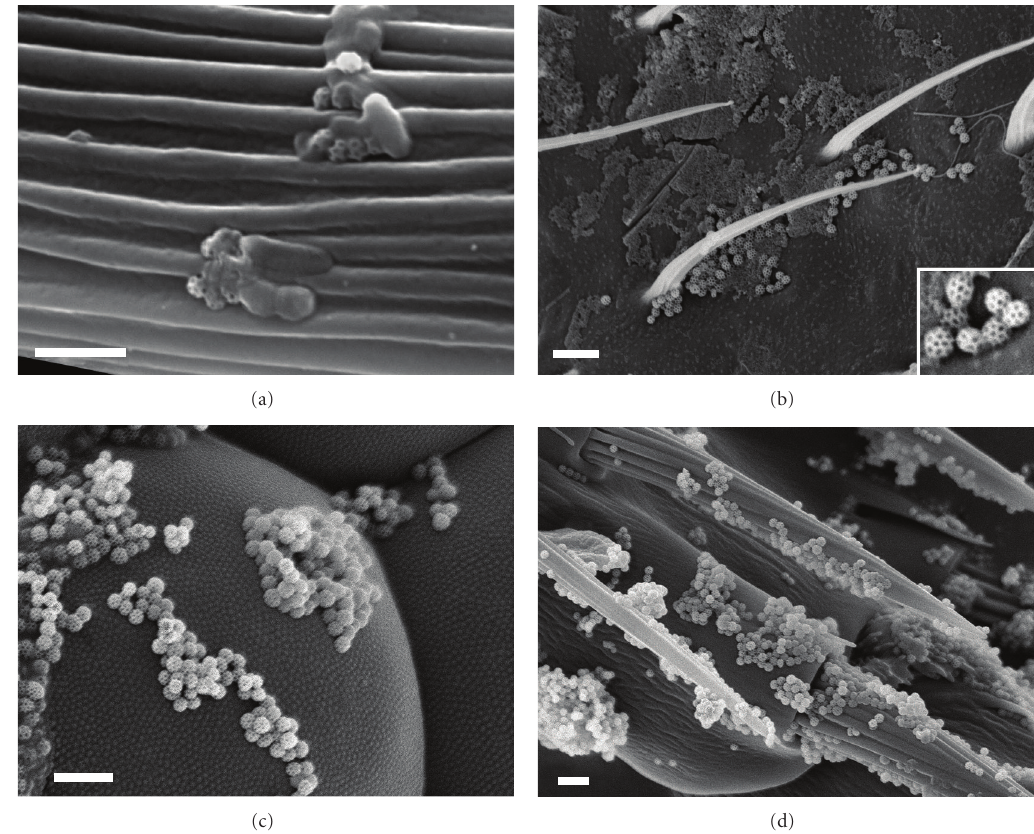
Figure 1: Insect integuments contaminated with brochosomes. (a) Pulvillus of Sthenarus rotermundi reared in captivity, showing the largest concentration of brochosomes (12 particles) observed among heteropteran specimens in this study and some bacteria. (b) Wing of Drosophila melanogaster kept in ethanol together with leafhoppers; inset: close-up of brochosomes. (c) Eye of D. melanogaster kept within a leafhopper-contaminated aspirator reservoir. (d) Tarsus of D. melanogaster kept within a leafhopper-contaminated aspirator reservoir. Scale bars: 2 µ m